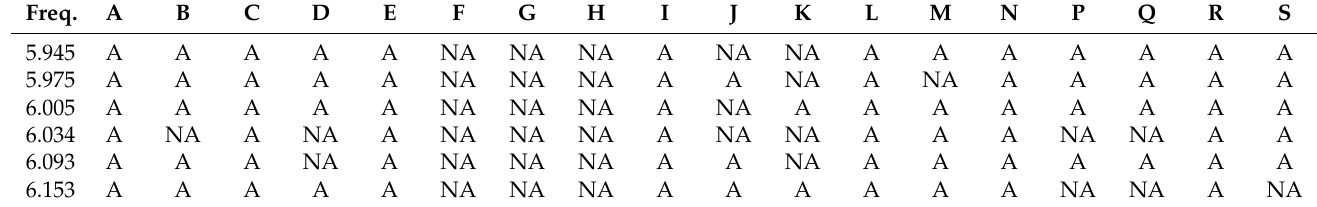
Table 5. The desired frequencies for the 18 channels at 6 GHz: Available (A); Not Available (NA). Freq.